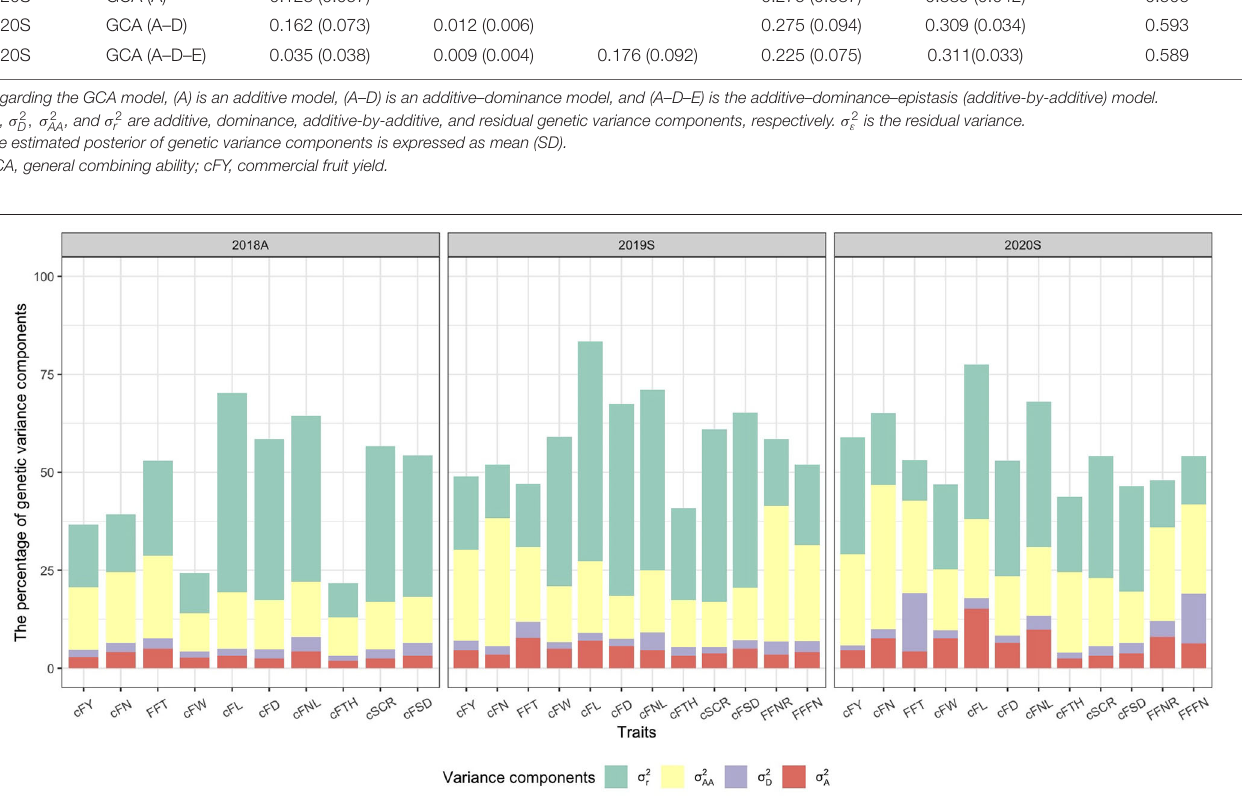
FIGURE 4 | The percentage of genetic variance components in the total variance among traits under the general combining ability (A–D–E) model. σ 2 A , σ 2 D , σ 2 AA , and σ 2 r are additive, dominance, additive-by-additive, and residual genetic variance components,